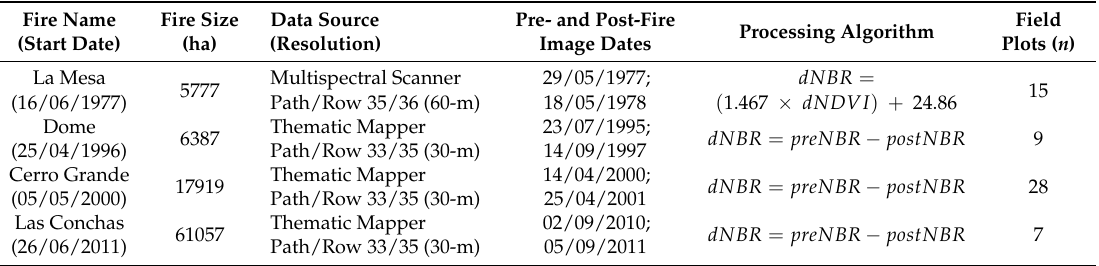
Table 2. Spatial data sources, processing methods and field sample count for the four